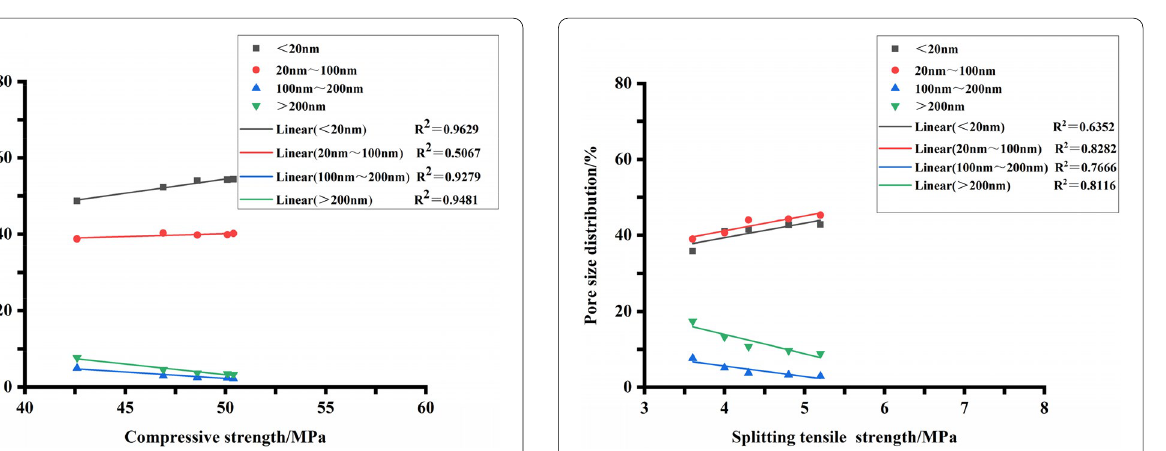
Fig. 21 Relationship between pore size distribution and compressive strength (BFRC2).